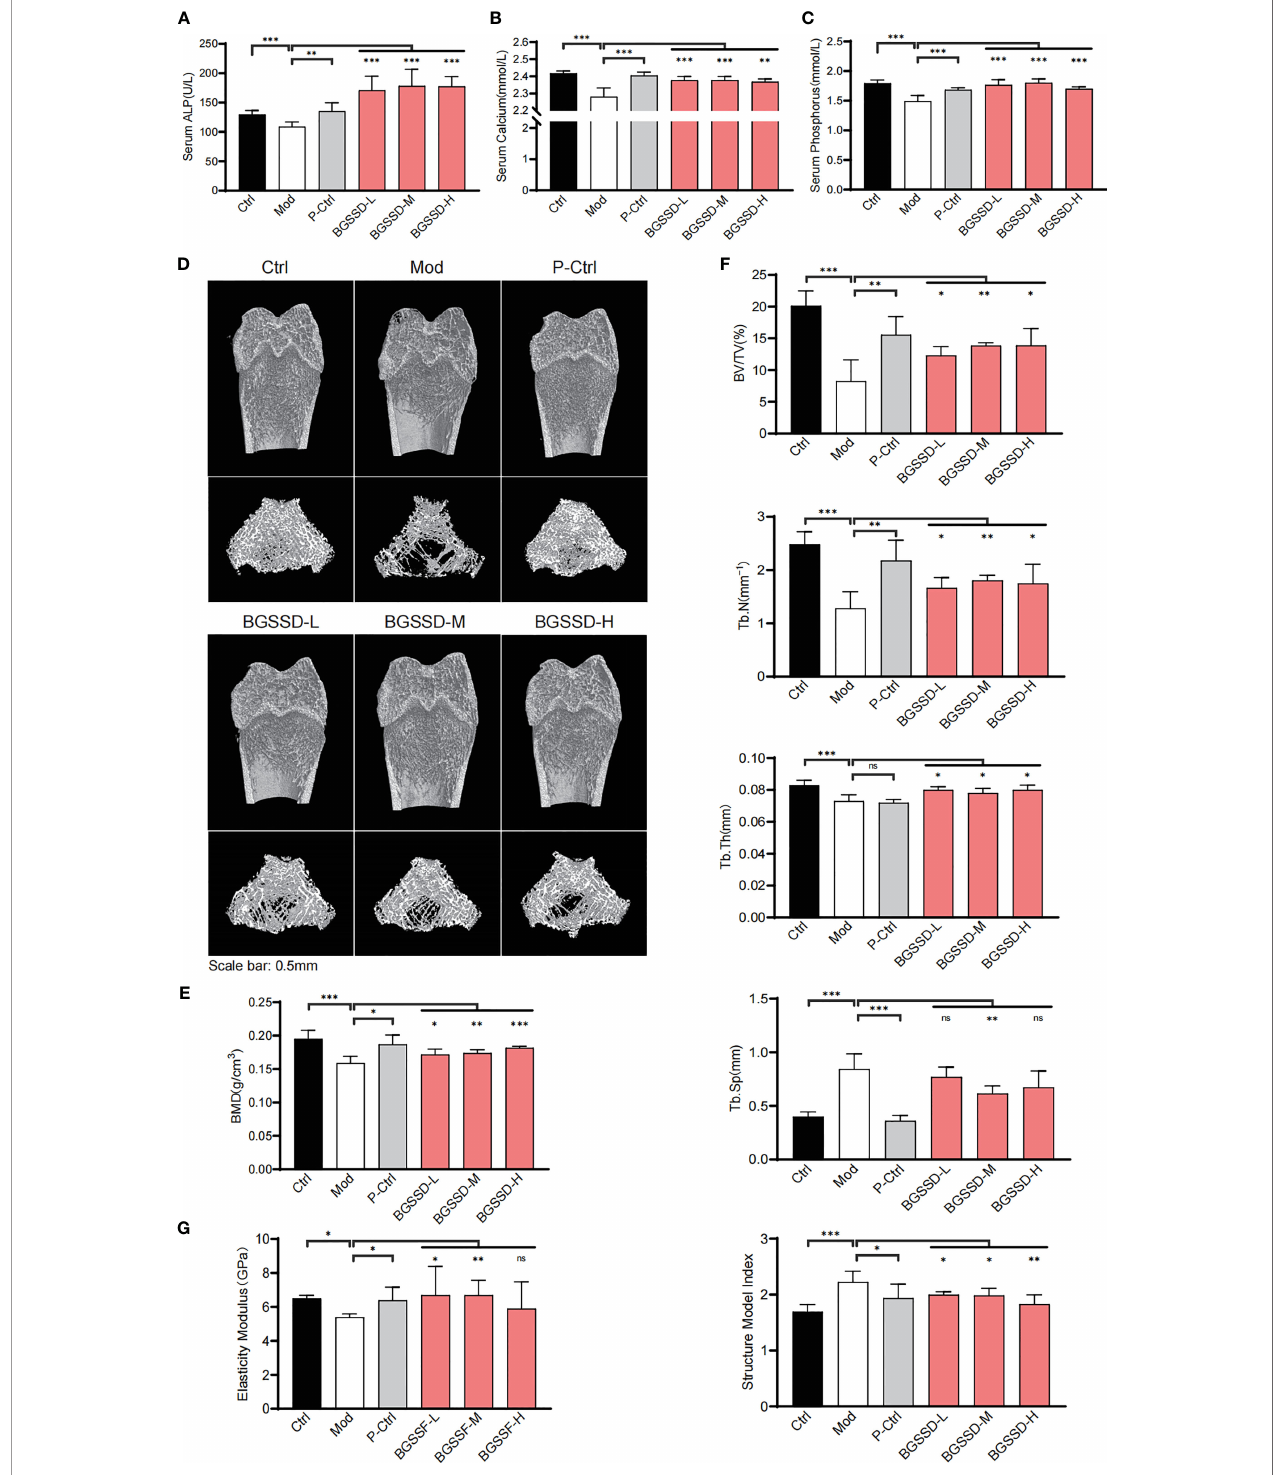
FIGURE 2 | The ef fi cacy results of BGSSD in the treatment of osteoporotic rats. (A – C) The effects of different doses of BGSSD on serum Alp, calcium, and phosphorus. (D) Representative photomicrographs of distal femur sections by m -CT. (E) Quantitative analysis of BMD (mg·ccm − 1 ) of femurs. (F) Quantitative analysis of the ratio of bone volume to tissue volume (BV/TV, %), trabecular number (Tb.N, mm -1 ), trabecular thickness (Tb.Th, mm), trabecular separation (Tb.Sp, mm), and the structural model index (SMI) of the m -CT-scanned distal femurs. (G) Quantitative analysis of the elastic modulus of femurs. The results are presented as the mean± s. e.m., *p < 0.05, **p < 0.01, *** p < 0.001, n = 6 per group. NS, not statistically signi fi